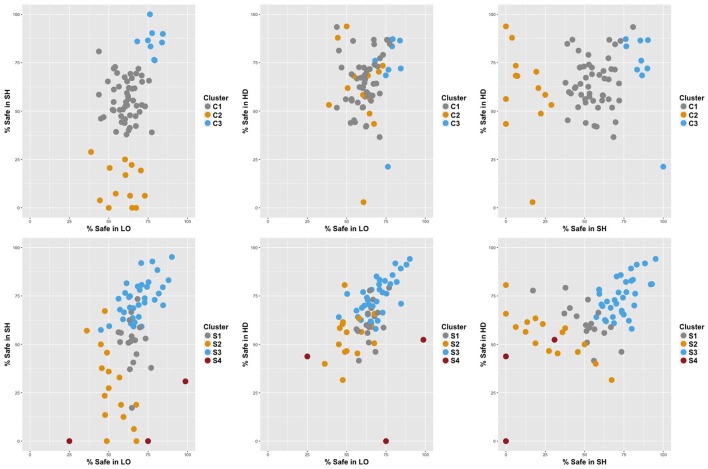
Representation of choices by cluster in the Control (Top) and Stress (Bottom) conditions.